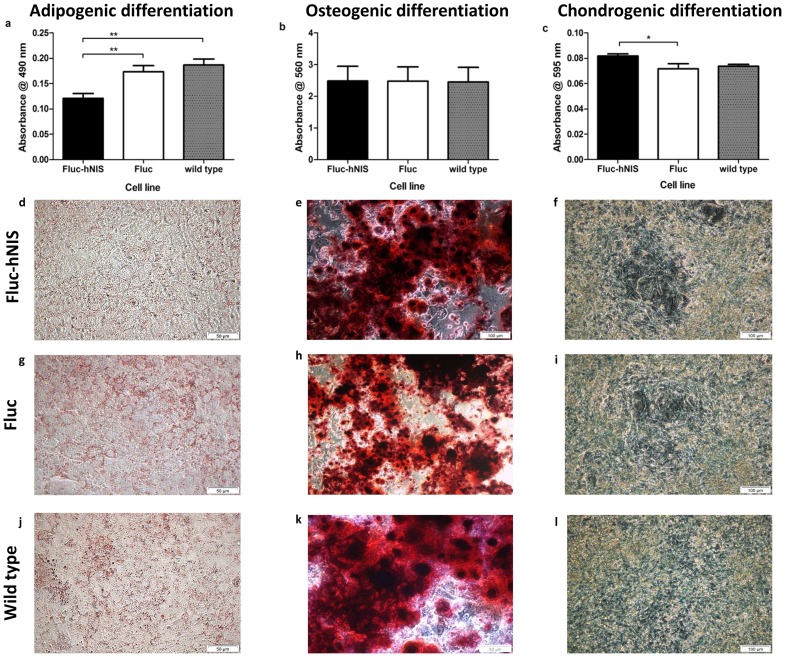
Adipogenic, osteogenic and chondrogenic differentiation capacity of Fluc-hNIS expressing MSCs, Fluc expressing MSCs and wild types.Extraction of the Oil red O dye following adipogenic differentiation measured at 490(a). Extraction of the Alizarin red S dye from differentiated osteoblast matrix, measured at 560 nm (b). Extraction of Alcian Blue dye from differentiated chondrocyte matrix, measured at 595 nm (c). *: p<0.05, **: p<0.01. Images of the Oil red O stainings (d,g,j), the Alizarin red S stainings (e,h,k) and the Alcian Blue stainings (f,I,l) for all conditions: Fluc-hNIS, Fluc expressing cells and wild types.